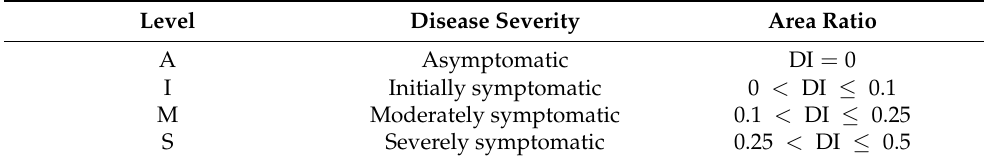
Table 1. Disease severity levels at the leaf scale.